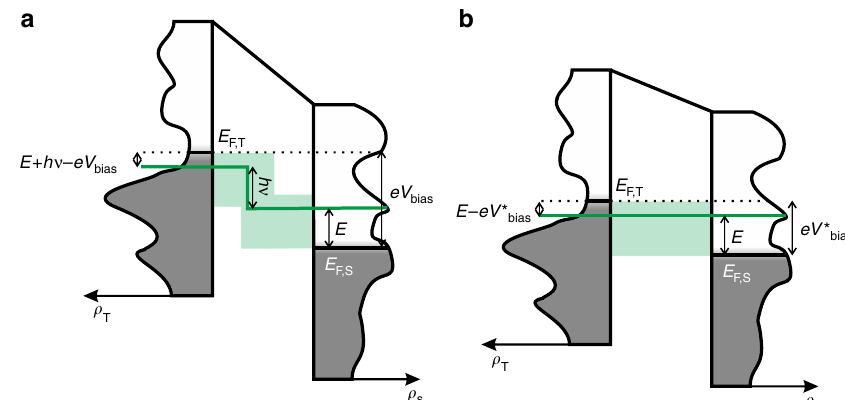
Fig. 3 Relation between the rate of inelastic events and the tunnelling current. a Sketch of an inelastic tunnelling event in which an electron crosses the tunnelling gap exciting a plasmon of energy h ν (green line). The light-green shaded region corresponds to all the inelastic processes that can contribute to plasmon emission for a given bias voltage. b Sketch of an elastic tunnelling event. The light-green shaded region corresponds to all the elastic processes that can contribute to the tunnelling current. Comparison of a , b shows that all the contributions to the inelastic channel correspond to contributions of the ¼ eV (cid:1) h ν elastic channel for a lower bias voltage eV (cid:4) bias bias